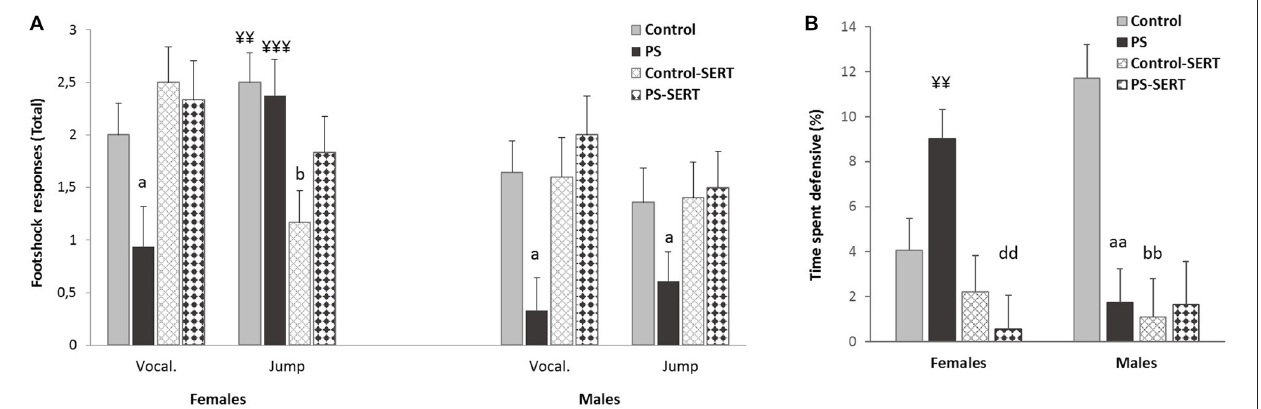
FIGURE 3 | Effects of prenatal stress and SERT treatment (5 mg/kg/day) over the course of the context-shocks pairing session. (A) Vocalization and jump intensity responses to footshock delivery, in the animals of both sexes; (B) time that rats spent defensive (expressed in percentage). Each bar represents the sum of the response’s intensity (ranging from 0 to 1), to the three footshocks presentation (of 0.35 mA each), expressed as Means + SEM ( n = 8–9 animals per group and sex). aa p < 0.01 and a p < 0.05, indicate the effect of prenatal stress; b p < 0.05 and bb p < 0.01 indicate the effect of SERT in controls; dd p < 0.01 indicate the effect of SERT in PS females; (cid:85)(cid:85) p < 0.01; (cid:85)(cid:85)(cid:85) p < 0.001, indicate the effect of sex within non-treated